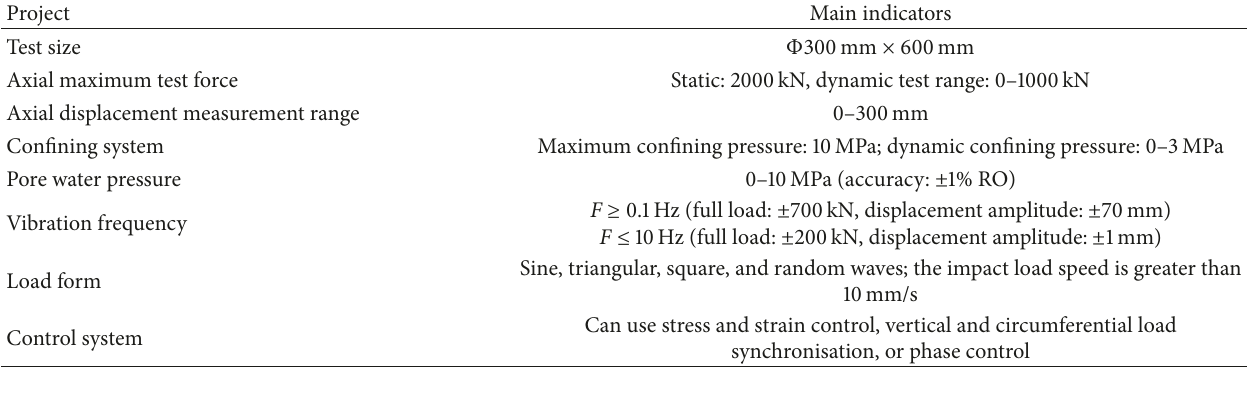
Figure 3: Steps of the uniaxial compression CT test: (a) sample, (b) sample installation, (c) test sample facade structure, and (d) data reading in the trial. Table 4: TAJ large moving and static triaxial instrument.